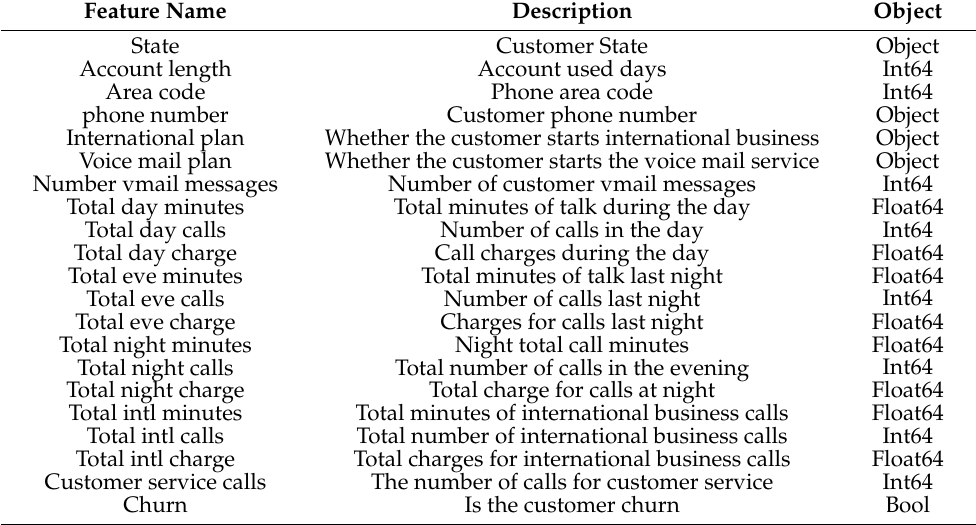
Table 1. Data-set description.